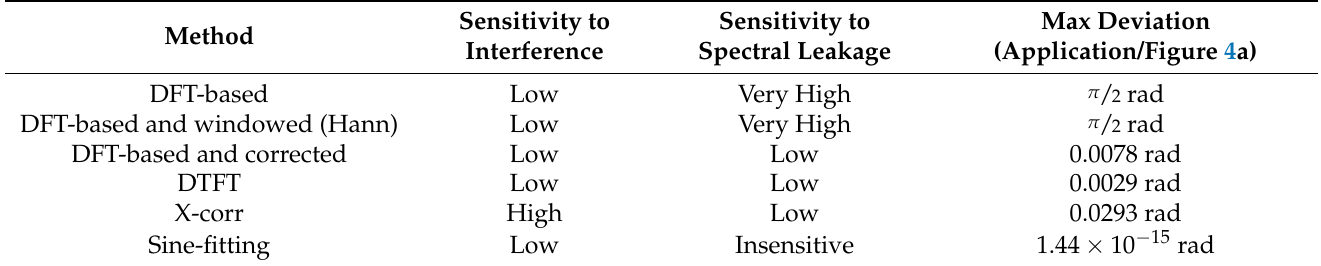
Table 5. Comparison between the sensitivity of the phase AC signal analysis methods to interference and to spectral